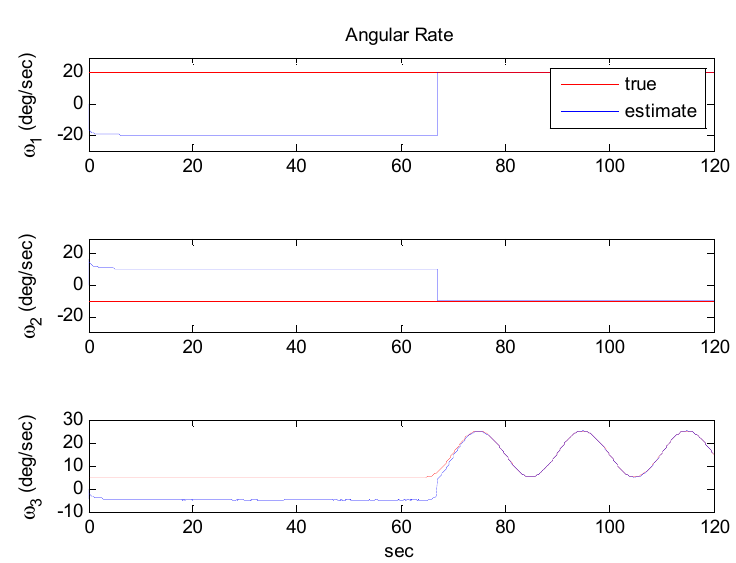
Figure 11. Angular rate estimation: Case 3-2.